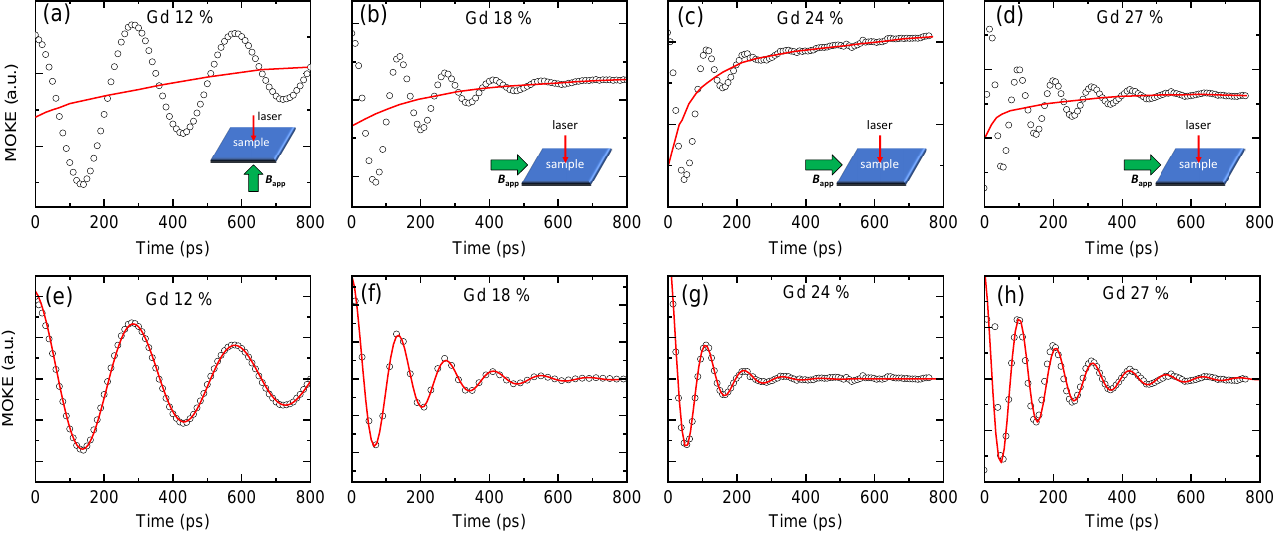
Figure 4. TRMOKE results. The magnetization dynamics triggered by a pump pulse in the ( a ) Gd 12 Co 88 , ( b ) Gd 18 Co 72 , ( c ) Gd 24 Co 76 , and (d) Gd 27 Co 73 alloys. A magnetic field of 0.5 T/0.3 T is applied along the z/x direction for ( a )/( b – d ). The black circles are the measure data. The red lines are the background demagnetization signal. The extracted precessional motion in the ( e ) Gd 12 Co 88 , ( f ) Gd 18 Co 72 , ( g ) Gd 24 Co 76 , and ( h ) Gd 27 Co 73 alloys. The black circles are obtained by subtracting the demagnetization background from the raw data of ( a – d ). The red lines are fittings by damped cosine function of cos ( 2 π ft ) × exp ( − t / τ ) . The fitted f values are 3.4, 7.2, 8.9, and 9.4 GHz for ( e – h ), respectively. The fitted τ values are 600, 160, 80, and 160 ps for ( e – h ),